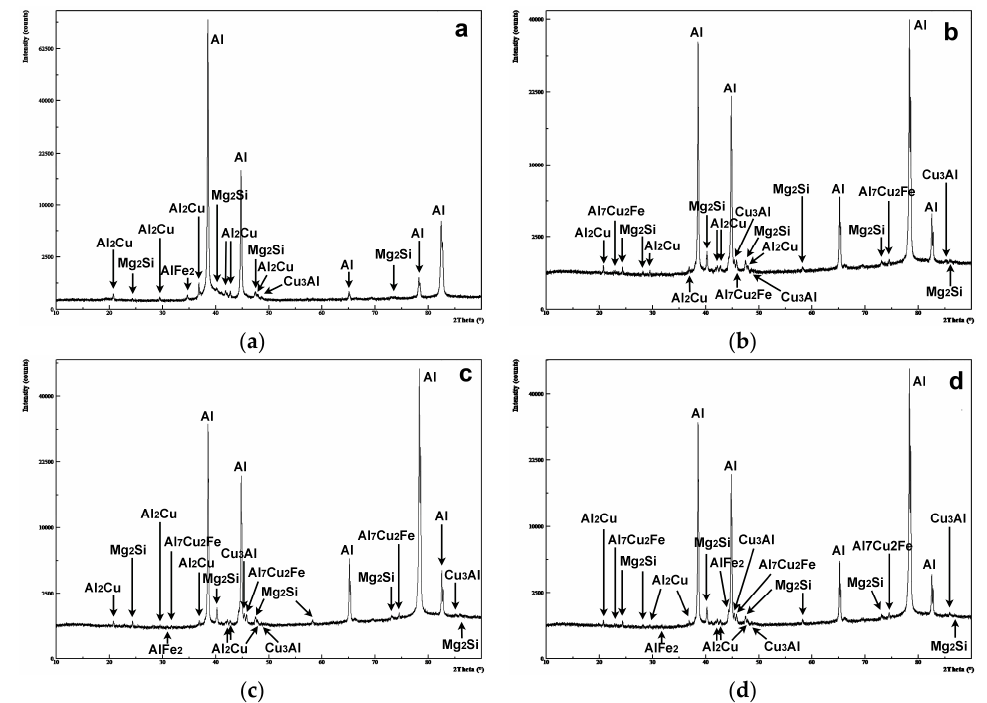
Figure 8. Diffractograms of the material obtained by X ‐ ray diffraction (XRD). ( a ) Identification of the phases present after hot rolling. ( b ) Identification of the phases present after a solution treatment at 495 °C for 4 h and natural ageing for up to 1000 h. ( c ) Identification of the phases present after a solution treatment at 495 °C for 8 h and natural ageing for up to 1000 h. ( d ) Identification of the phases present after a solution treatment at 495 °C for 24 h and natural ageing for up to 1000 h. Table 2. Semi ‐ quantitative analysis obtained by means of the reference–intensity ratio (RIR) method. Crystalline Phases. AsCast.